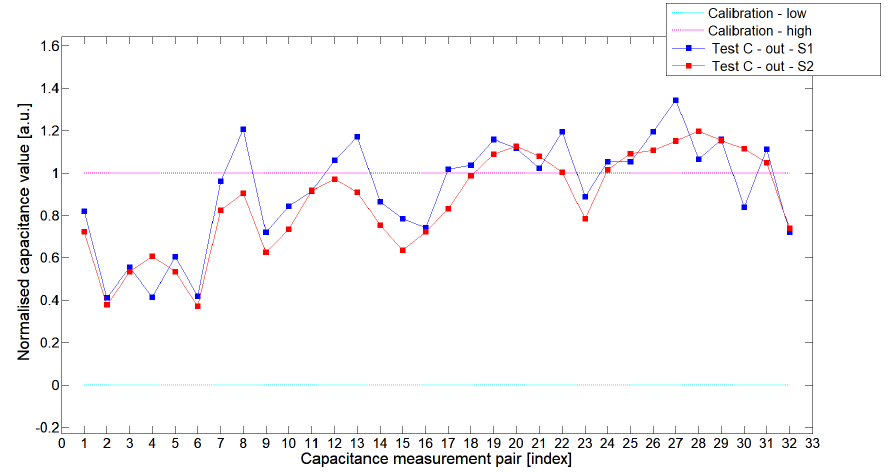
Figure 13. The 1st electrode measurement cycle (S1: 1->32 and S2: 1->32) for Test C out and S1—blue line, S2—red line. Cyan and magenta lines indicate calibration limits